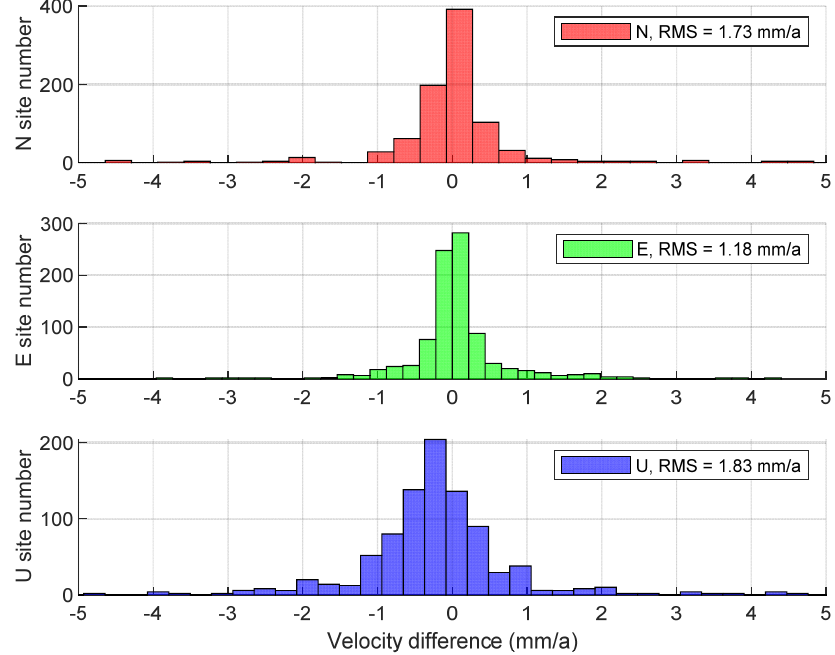
Figure 18. Difference of velocity field between ITRF2014 and GGV2020.